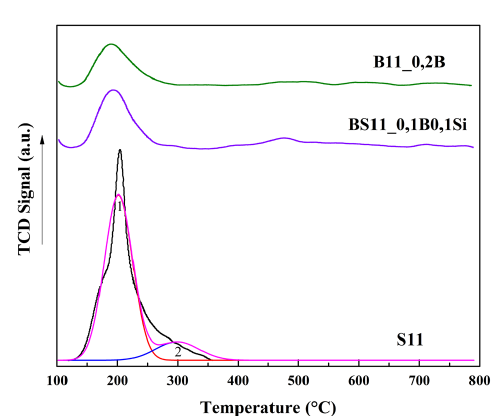
profiles of AEL samples obtained at different 3